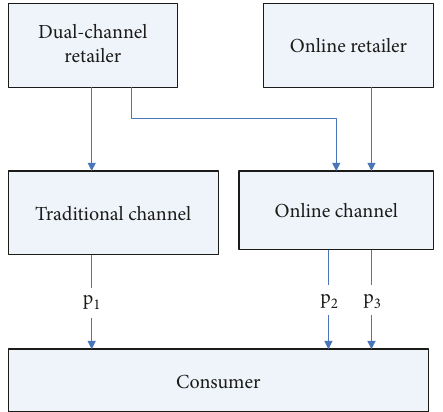
Figure 1: Dual-channel supply